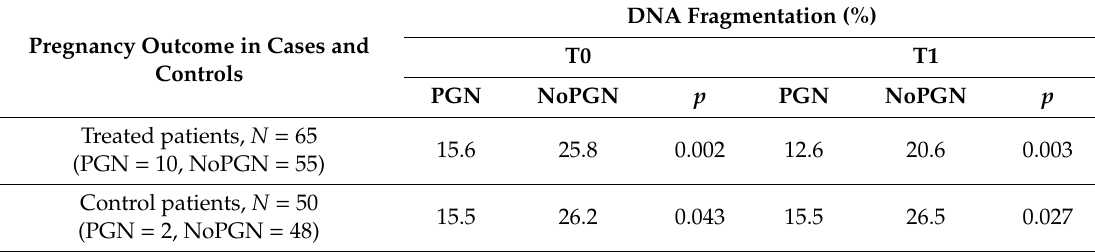
Table 2. DNA fragmentation (%) observed at T0 and T1 in cases and controls divided on the basis of positive or negative pregnancy outcome. PGN = pregnancy, NoPGN = no pregnancy.